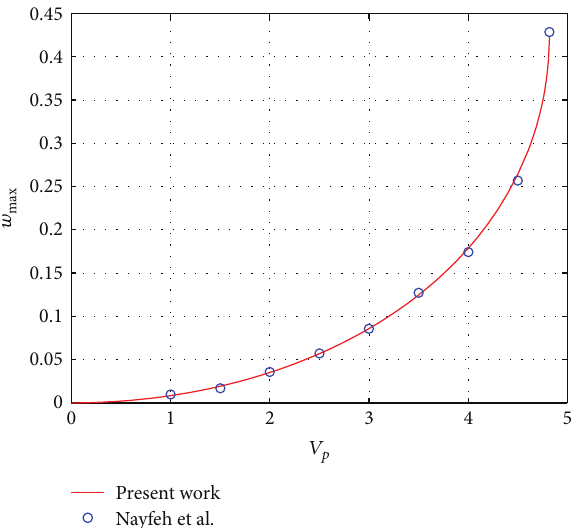
Figure 2: Static normalized midpoint deflection 𝑤 max with DC voltage 𝑉 𝑝